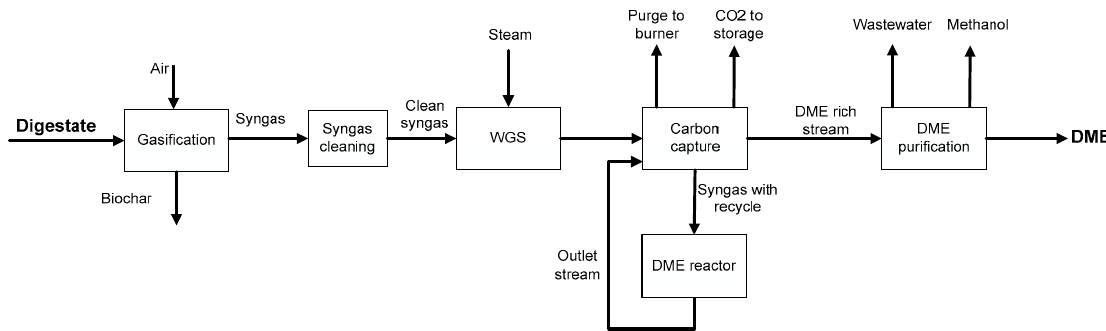
Figure 2. Block flow diagram of the production of DME by gasification of digestate and direct synthesis.